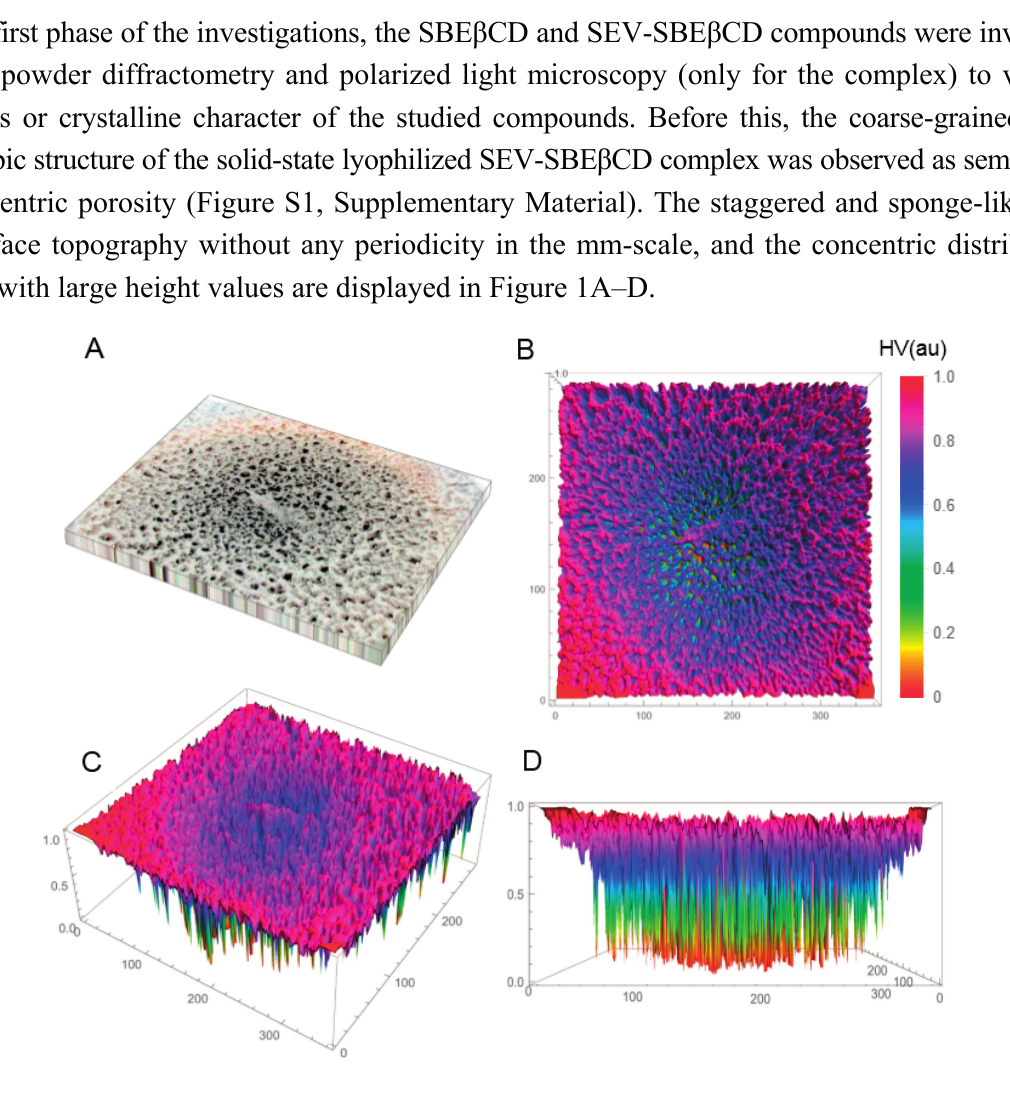
Figure 1. Reconstructed 3D structure of the solid-state lyophilized SEV-SBE β CD before grinding taken by a normal digital camera ( A ); The top ( B ); default ( C ); and front ( D ) view of the SEV-SBE β CD surface 3D plot was generated to evaluate and visualize the porosity using the array of height values (HV) measured in arbitrary units (au) with hue color function. The substance was in a round bottom flask, and the material in the photo represents an approximately 50 × 40 mm